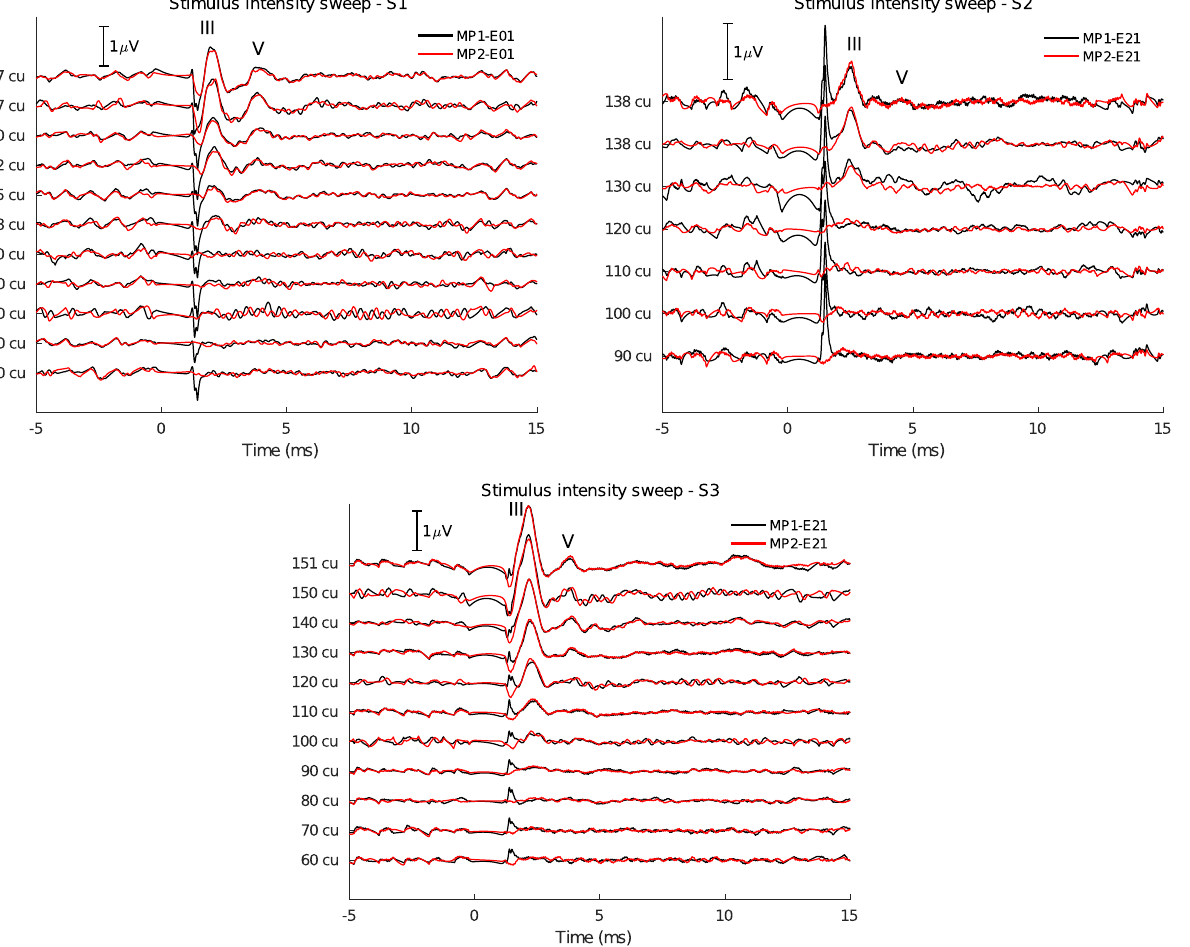
Figure 2. EABRs recorded at varying stimulus intensities. Waves III and V are marked on the traces. The recording at the loudest comfortable level was repeated twice. Electrical stimulation through the CI was bipolar using electrodes E21-E13 for S1 and E04-E12 for S2 and S3. The intracochlear recording electrode depends on the subject (S1: E01, S2 and S3: E21). Stimulation intensity is given in current units (cu), a logarithmic